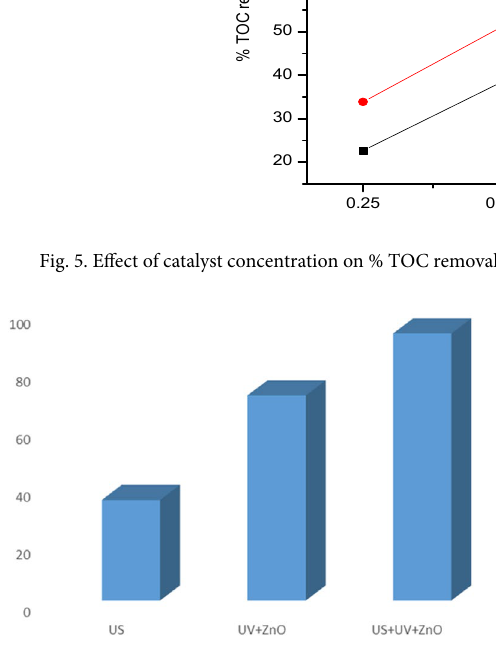
Fig.6.Comparison ofultrasonic, photocatalytic and sonophotocatalyticprocesses for degradation oftextile industrial effluentat pH7,ZnOdose Fig. 6. Comparison of ultrasonic, photocatalytic and 1 g/L, contact time 160 min.and US power 150 W sonophotocatalytic processes for degradation of textile industrial effluent at pH 7, ZnO dose 1 g/L, contact time 160 min. and US power 150 W